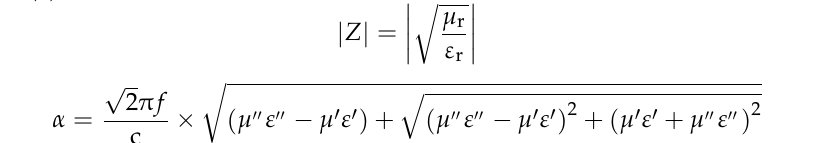
Figure 5. ε′ ( a ), ε″ ( b ), tan δ ε ( c ), μ′ ( d ), μ″ ( e ), and tan δ μ ( f ) of B,N-CNTs. The impedance matching (| Z |) and attenuation constant ( α ) are also the key factors to determine the MA performance of materials, which the calculation equations are pre- sented in (3) and (4).